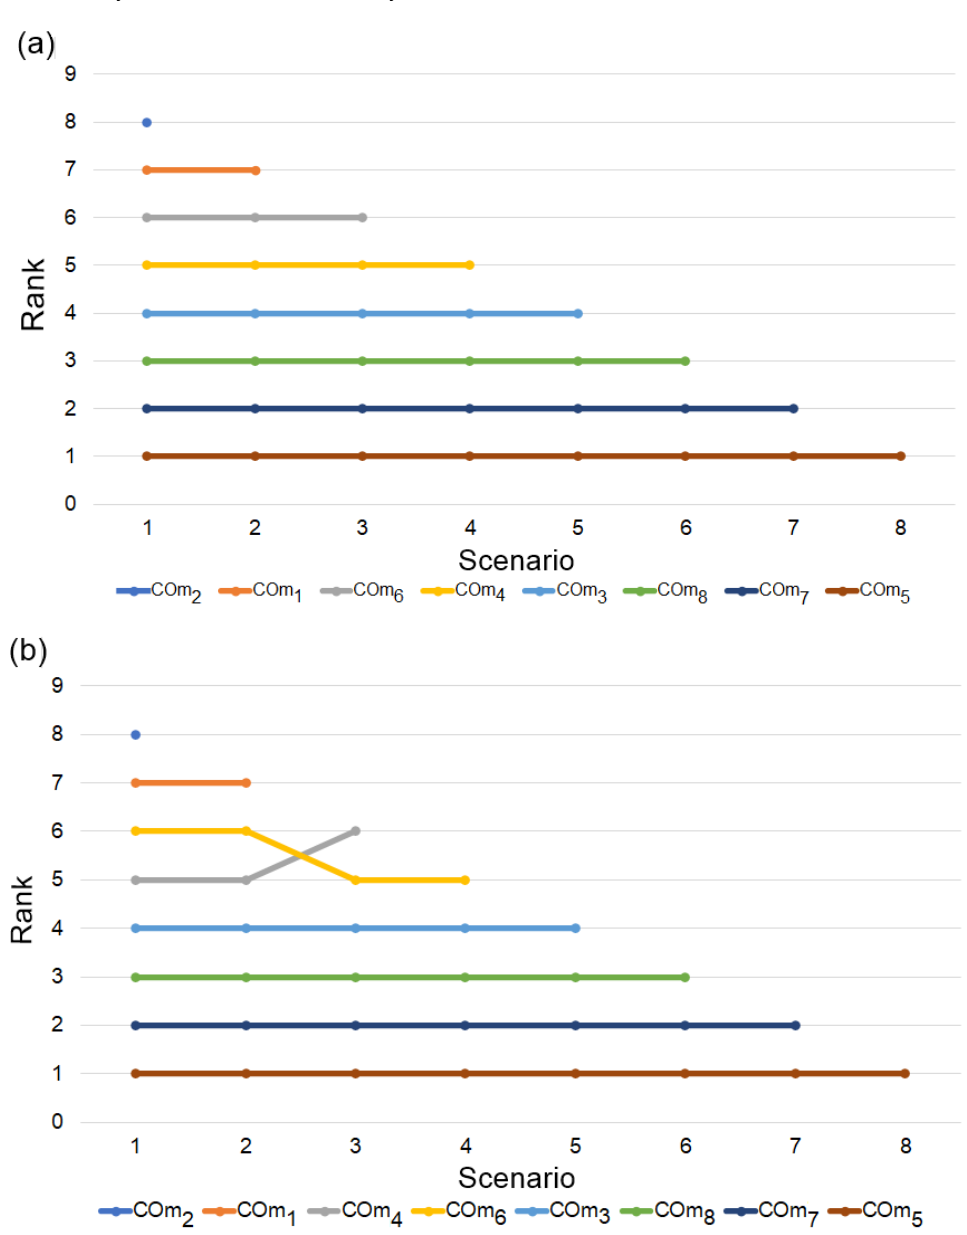
Figure 3. Effect of dynamic matrices on the ranking of alternatives derived using ( a ) fuzzy-MARCOS and ( b ) fuzzy-TOPSIS.